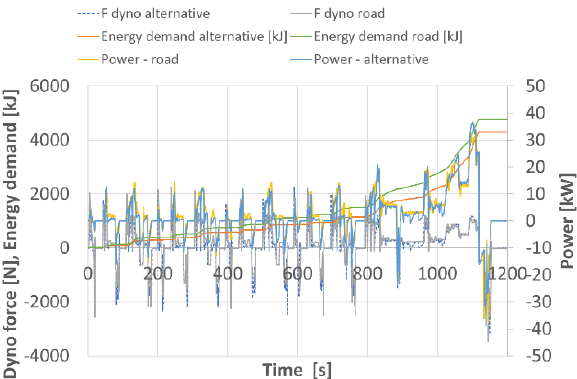
Fig. 3. Sample of measured dyno forces, dyno power and energy demand for road and alternative resistance functions